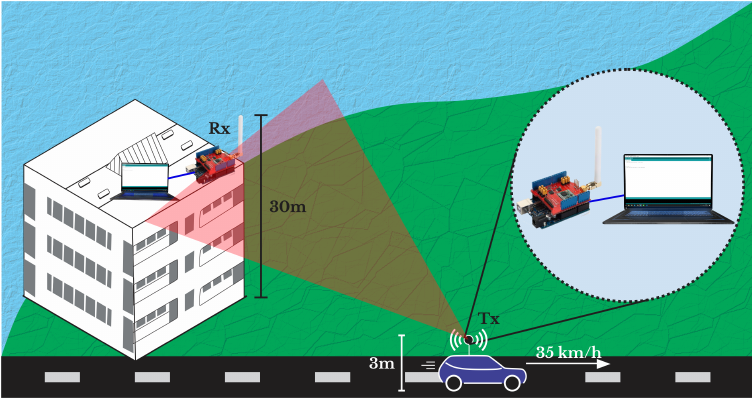
Figure 4. Measurement